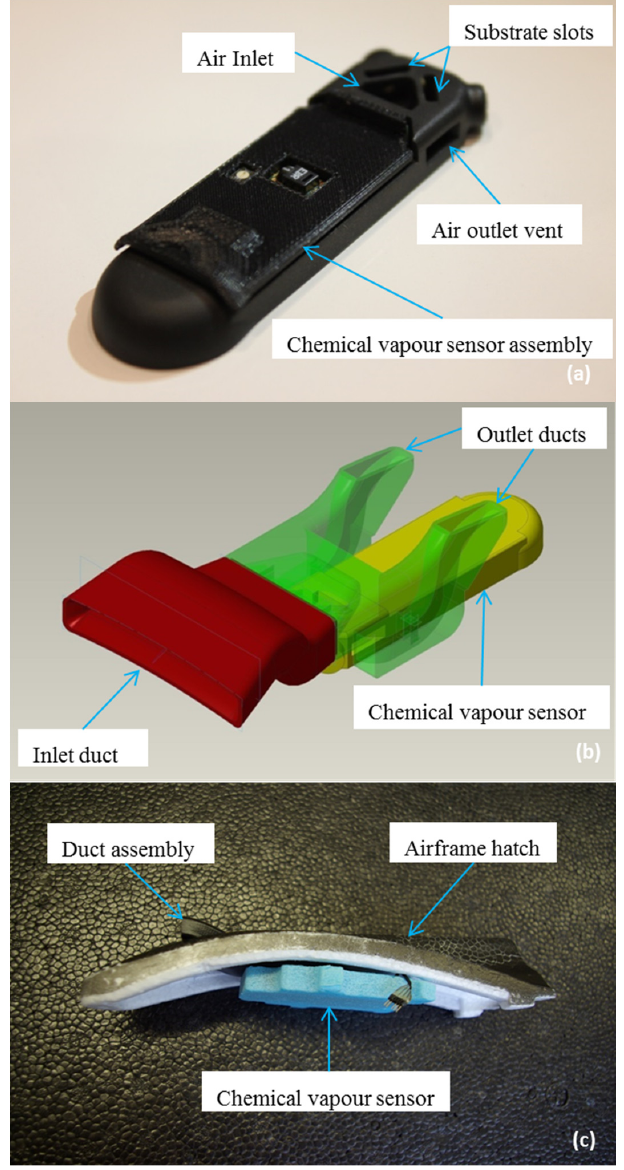
Figure 1. ( a ) Chemical vapour sensor; ( b ) design of the air scoop duct assembly with integrated sensor; and ( c ) side view of assembly integrated into the micro-UAV cover hatch.